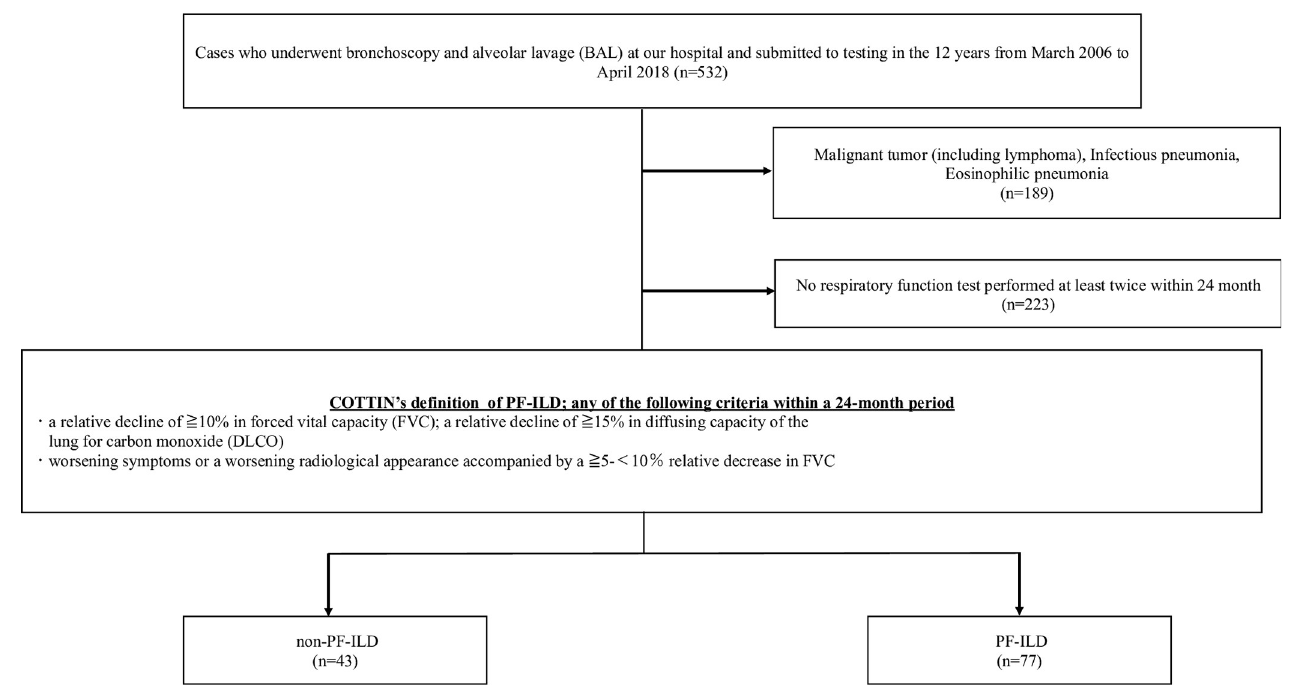
Fig 1. Population flow chart of the study cohort. Among 532 patients who underwent bronchoscopy and BAL, 189 patients with diseases not relevant to the objective of this study and 223 who did not undergo a respiratory function test were excluded. Eventually, 120 patients were included in the analysis. PF-ILD: progressive fibrosing interstitial lung disease; BAL: bronchoalveolar lavage.